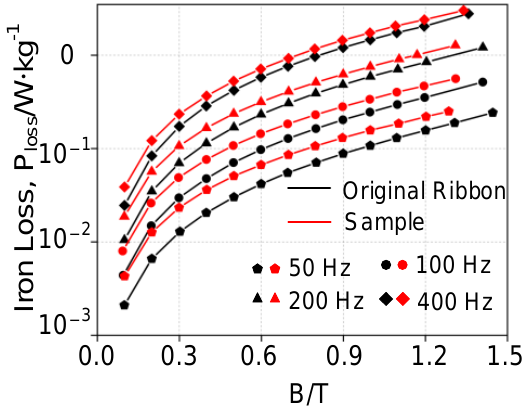
Figure 6. Core loss curves of the AA samples at different